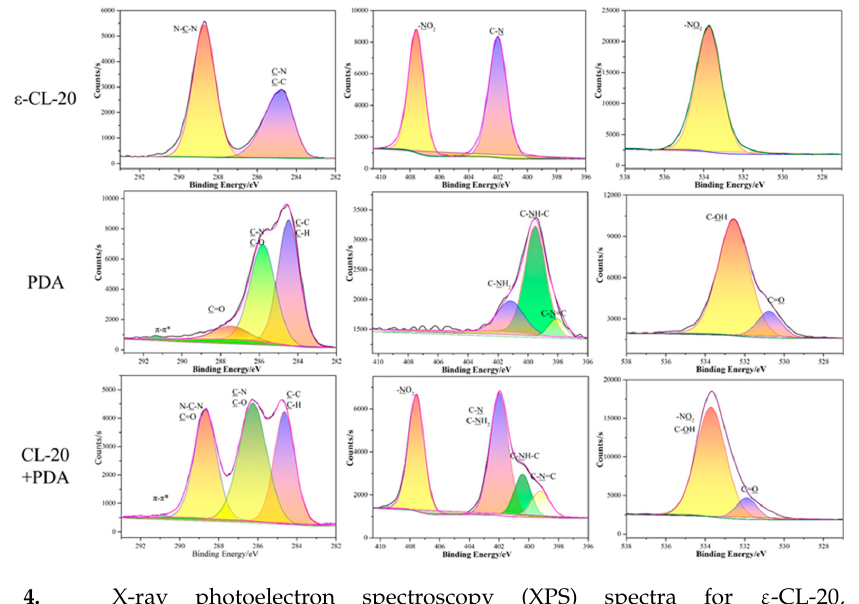
Figure 4. X ‐ ray photoelectron spectroscopy (XPS) spectra for ε‐ CL ‐ 20, PDA, and ε‐ CL ‐ 20/PDA composites.